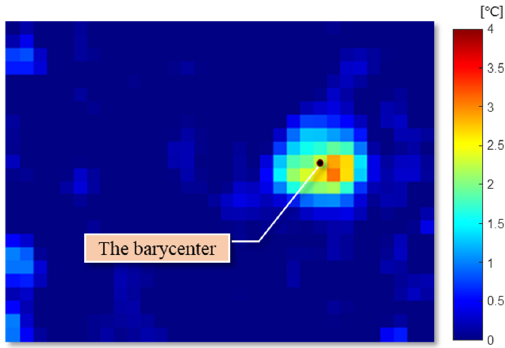
Figure 6. The adjusted center point of the target in the infrared data.